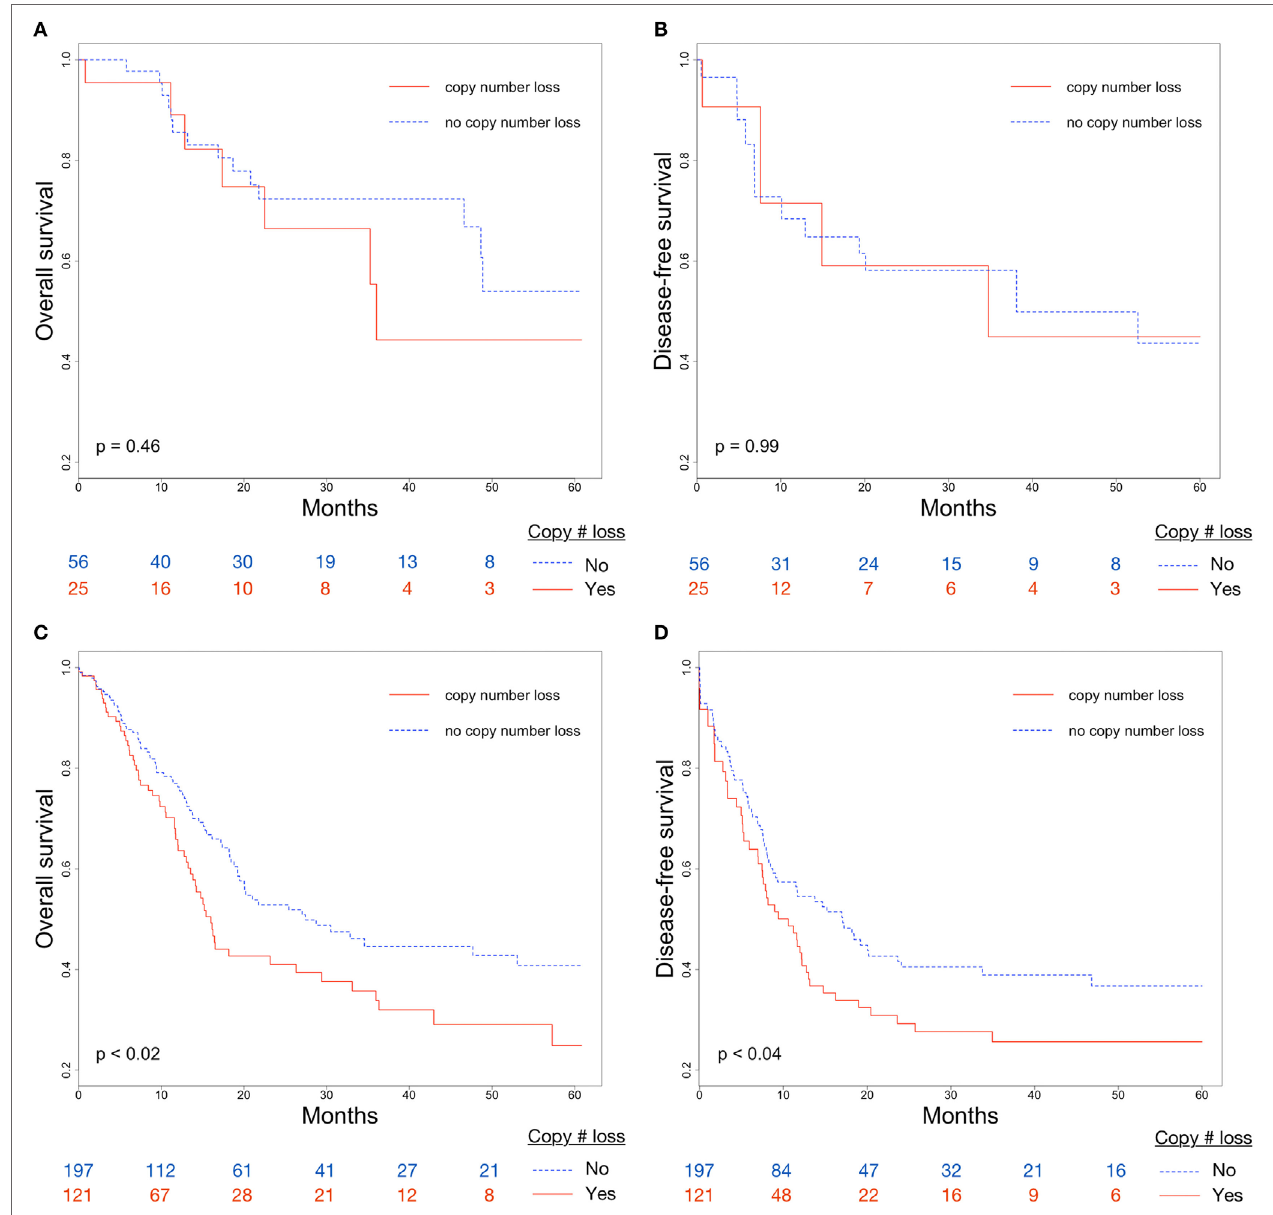
FigUre 3 | Differences in (a) overall survival (OS) and (B) disease-free survival (DFS) between CDKN2A copy number loss and non-copy number loss groups for early-stage (stage I/II) tumors; Differences in (c) OS and (D) DFS between CDKN2A copy number loss and non-copy number loss groups for advanced-stage (stage III/IV)